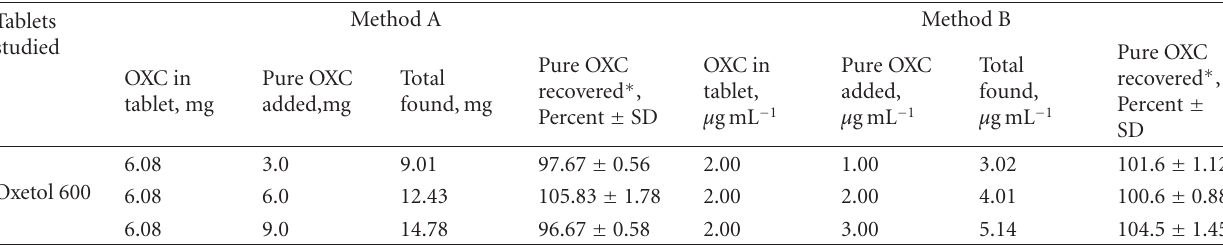
Mean value of five determinations. Table 5: Accuracy assessment by recovery